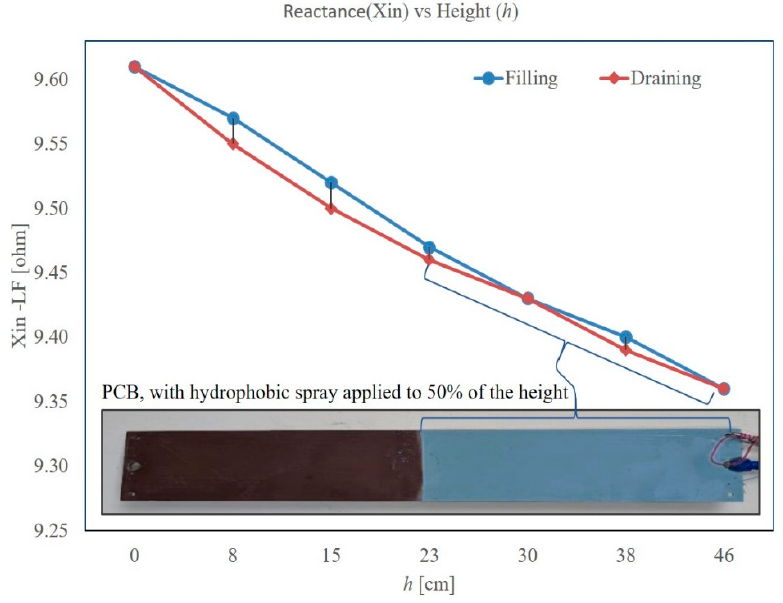
Figure 5. Hysteresis and effect of hydrophobic coating.